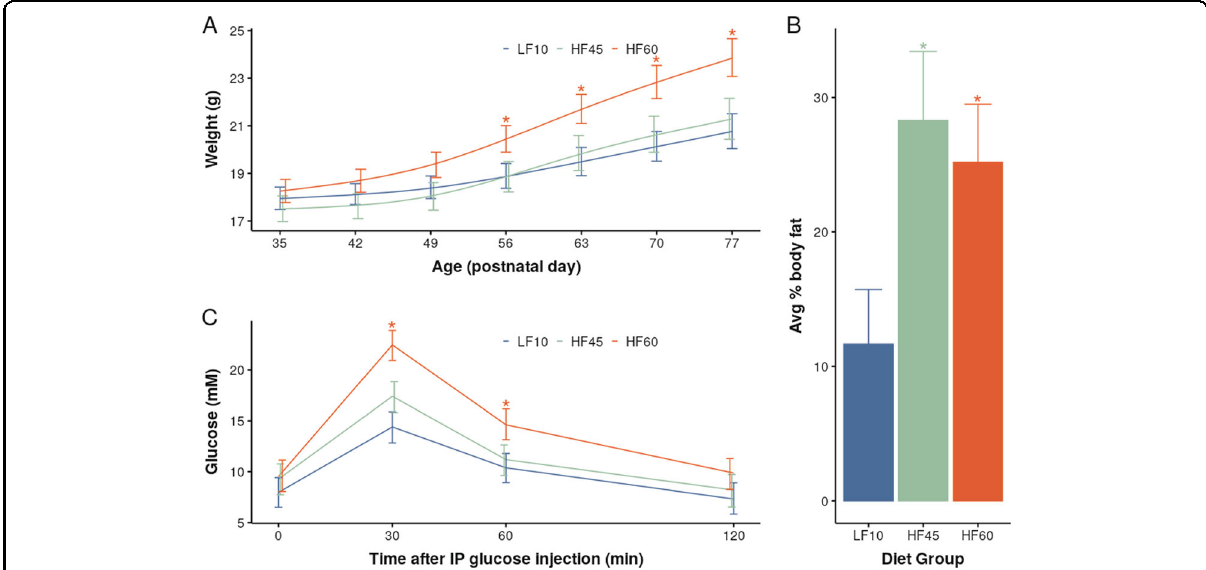
Fig. 1 High-fat diet induced metabolic changes in dams. A Body weights were signi fi cantly affected by diet ( χ 2 8 = 41.8, p < 10 − 5 ), primarily driven by a diet-time interaction ( χ 2 6 = 36.9, p < 10 − 5 ). A signi fi cant difference between LF10 and HF60 groups emerged at ~2 – 3 weeks after the experimental diet was introduced. B Average body-fat percentage was signi fi cantly affected by diet (HF45-LF10 difference = 16.6%, p < 10 − 3 ; HF60- LF10 difference = 13.5%, p < 10 − 3 ). C GTT showed a signi fi cant difference in glucose levels 30 min. (difference = 8.04 mM, p < 10 − 8 ) and 60 min. (difference = 4.25 mM, p < 10 − 2 ) between the LF10 and the HF60 groups. All bars represent 95% con fi dence intervals. Asterisks represent a signi fi cant difference from LF10 ( p <